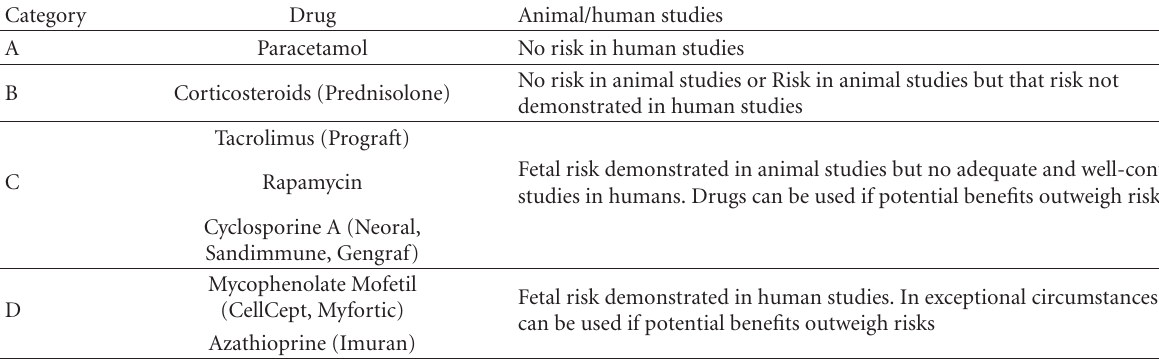
Table 1: Immunosuppressant risk categories according to US Food and Drug Administration [18].